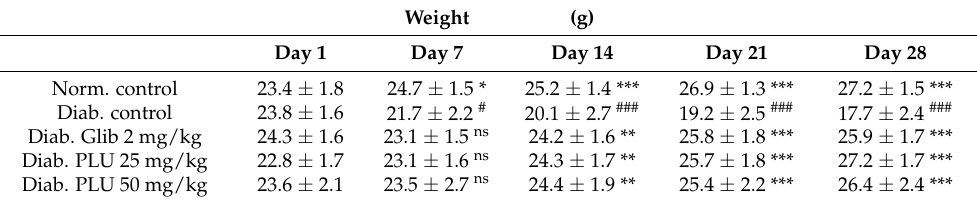
Table 2. Body weight changes of normal and diabetic mice during the treatment period. Weight (g) Norm. control